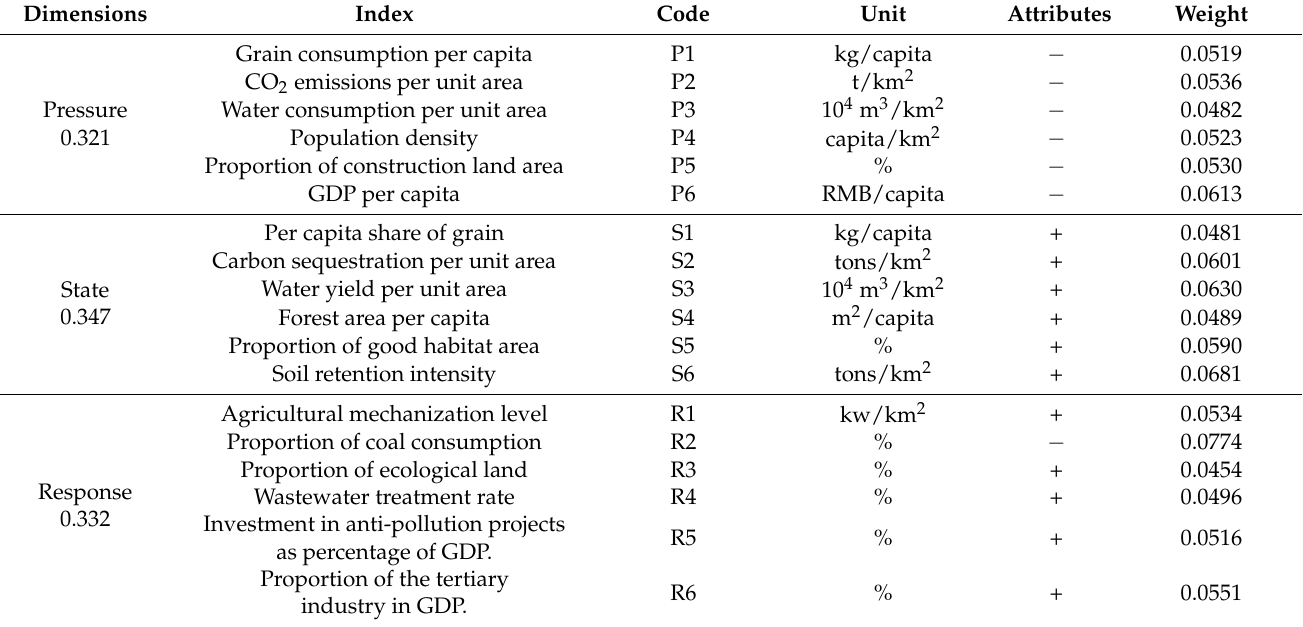
Table 3. The evaluation index system and their weights of ecological security for the Pearl River Delta.